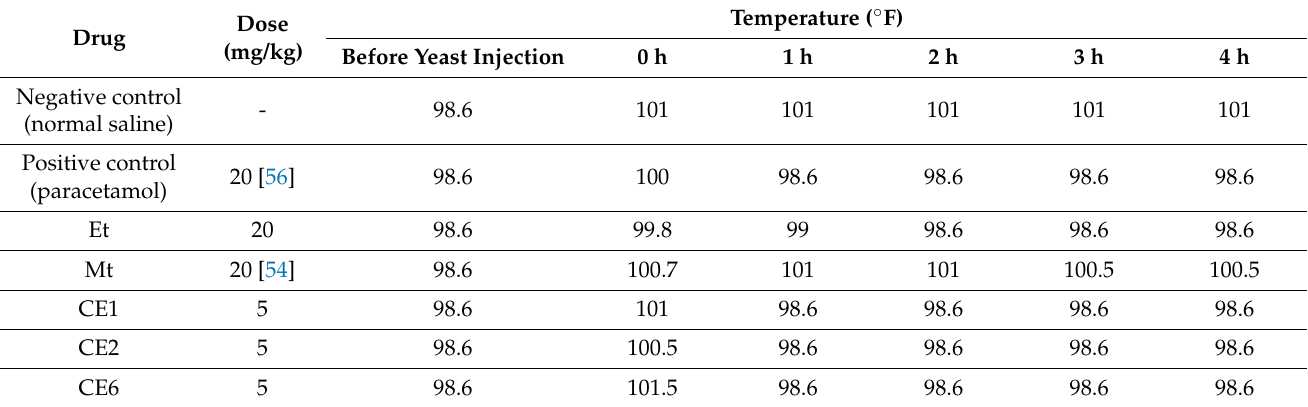
Table 6. In vivo anti-pyretic